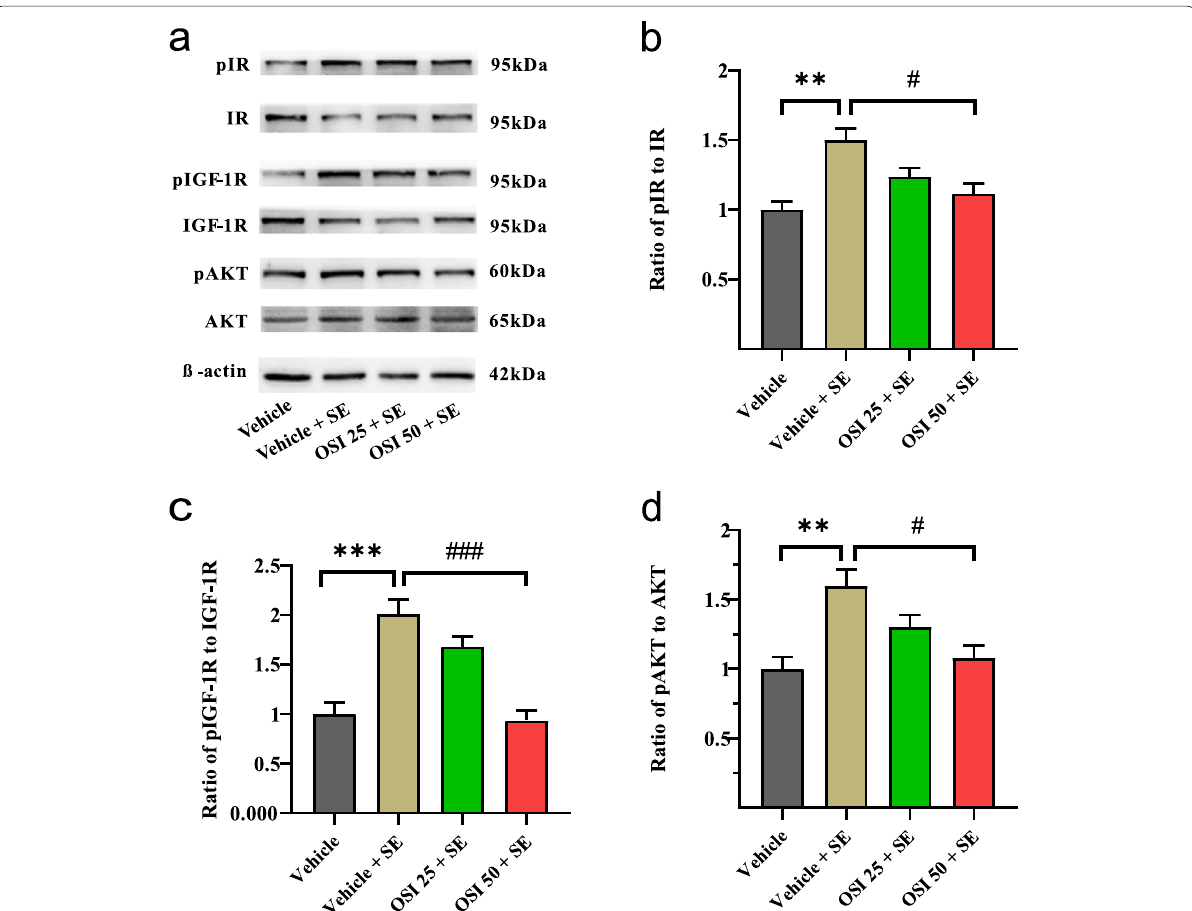
Fig. 7 Effects of OSI-906 on IR, IGF-1R and AKT signaling. ( a ) The representative bands of western blotting. ( b - d ) The pIR/IR, pIGF-1R/IGF-1R, and p-Akt/Akt ratios were significantly elevated at 24 h after pilocarpine-induced seizures, compared with those in the vehicle group. Compared to those in the seizure group, these ratios were markedly reduced in the 50 mg/kg OSI-906 group. Data are shown as mean ANOVA,** P < 0.01, *** P < 0.001, # P < 0.05, ### P <